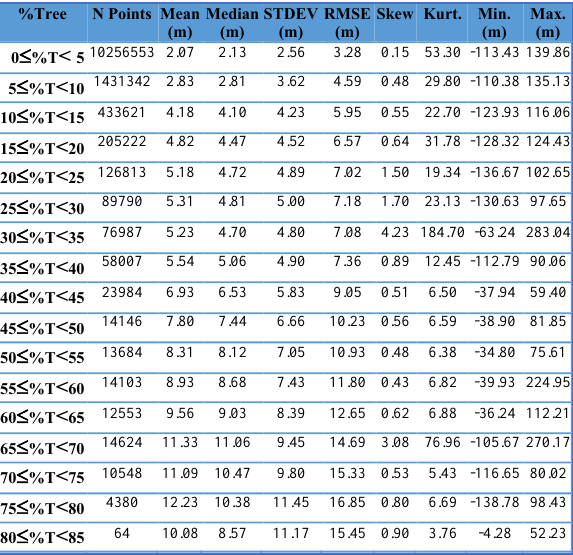
Table 3. Statistics for elevation differences between SRTM 90 m and ATL08 h_te_interp (in m) with respect to Landsat Percent Tree cover Continuous Fields for each 100 m segment. Percent Tree cover Mean, Median, Standard Deviations and RMSEs are shown for increments of 5% Tree cover.